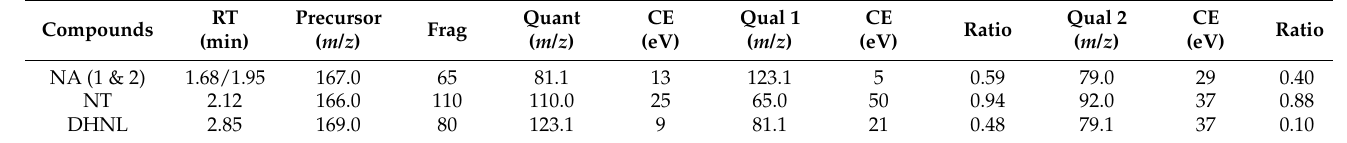
Table 5. Multiple reaction monitoring (MRM) parameters for catnip bioactive